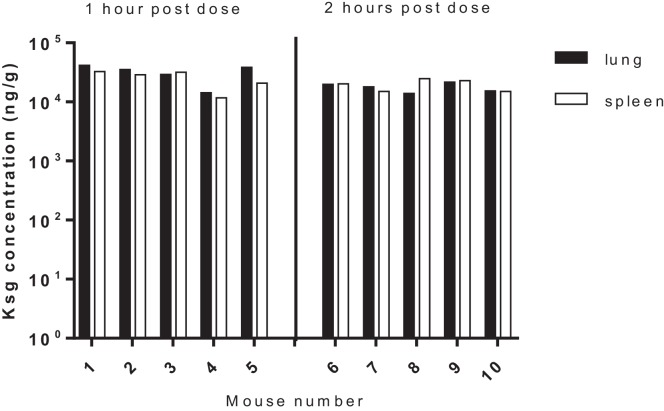
Tissue (lung/spleen) pharmacokinetics of kasugamycin following intra-peritoneal administration.Tissue homogenates were used for PK analysis.